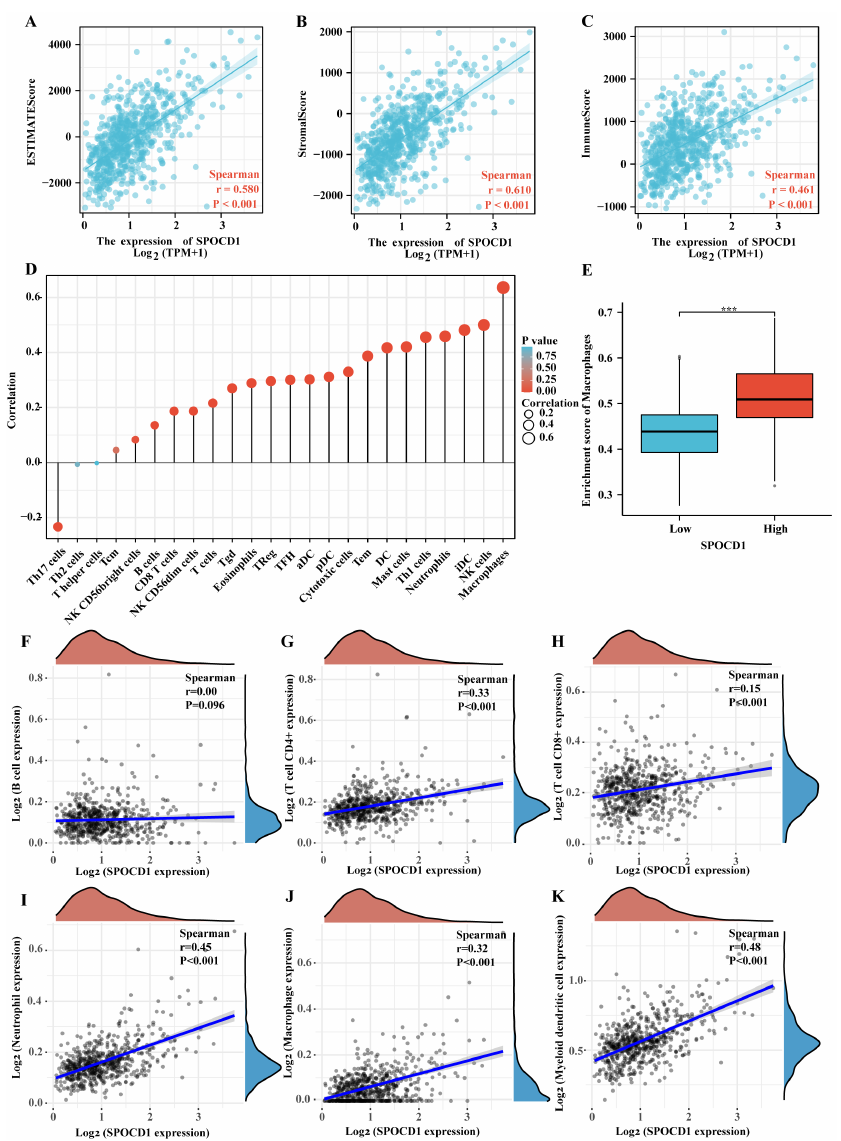
Figure 4. The correlation of SPOCD1 expression with tumor microenvironment and immune infil- tration level in CRC. ( A – C ) The correlation between SPOCD1 expression and the ESTIMATE, stro- mal, and immune scores based on the ESTIMATE algorithm. ( D ) The lollipop plot shows the corre- lation of SPOCD1 expression with immune cell infiltration conducted by ssGSEA. ( E ) Enrichment score of macrophages according to the difference SPOCD1 expressions. ( F – K ) The correlation of SPOCD1 expression with immune cell infiltration in CRC acquired from the TIMER online tool. (*** p < 0.001).